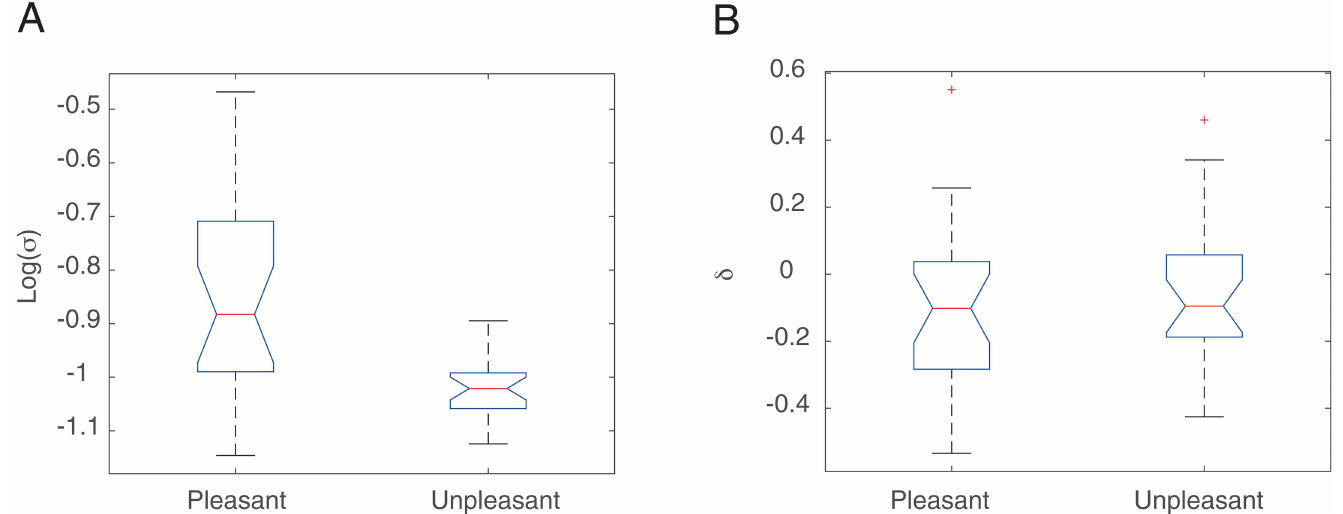
Fig 5. Estimated parameters of the two parametermodel in Session 1. A . The noise parameter σ . The effect of Room manipulation (the difference between Pleasant and Unpleasant population) was significant. B . The bias parameter δ . The effect of Room manipulation (the difference between Pleasant and Unpleasant population) was not significant.